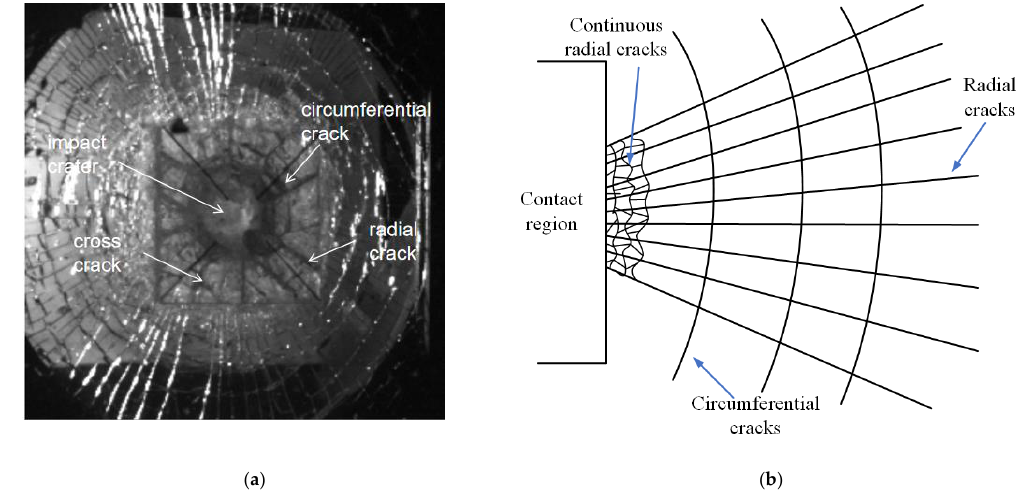
Figure 5. ( a ) Details of damage in ceramic glass layer; ( b ) Schematic drawing of features seen in inorganic glass